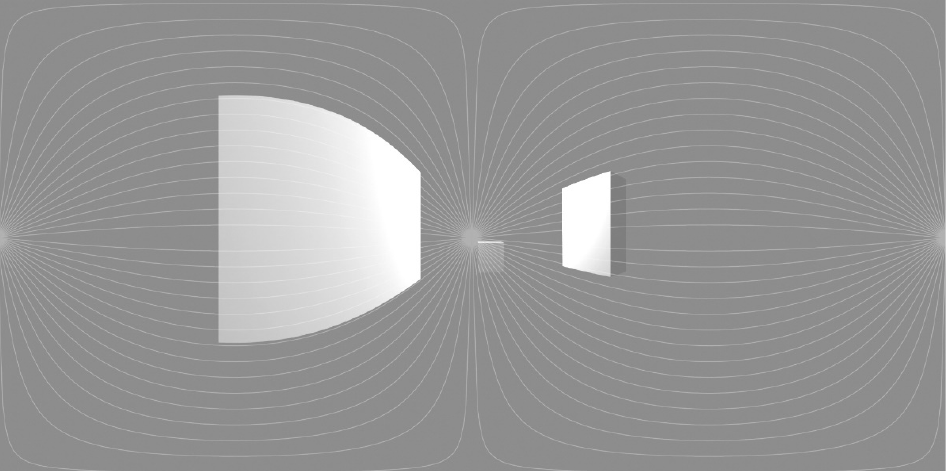
Figure 6. Spherical perspective rendering produced in Blender with an overlay of curves representing the first and third dimensions according to the formula in [34] (cylindrical roll-out) and the second dimension in vertical lines according to the torus-like roll-out of the grid in this direction.